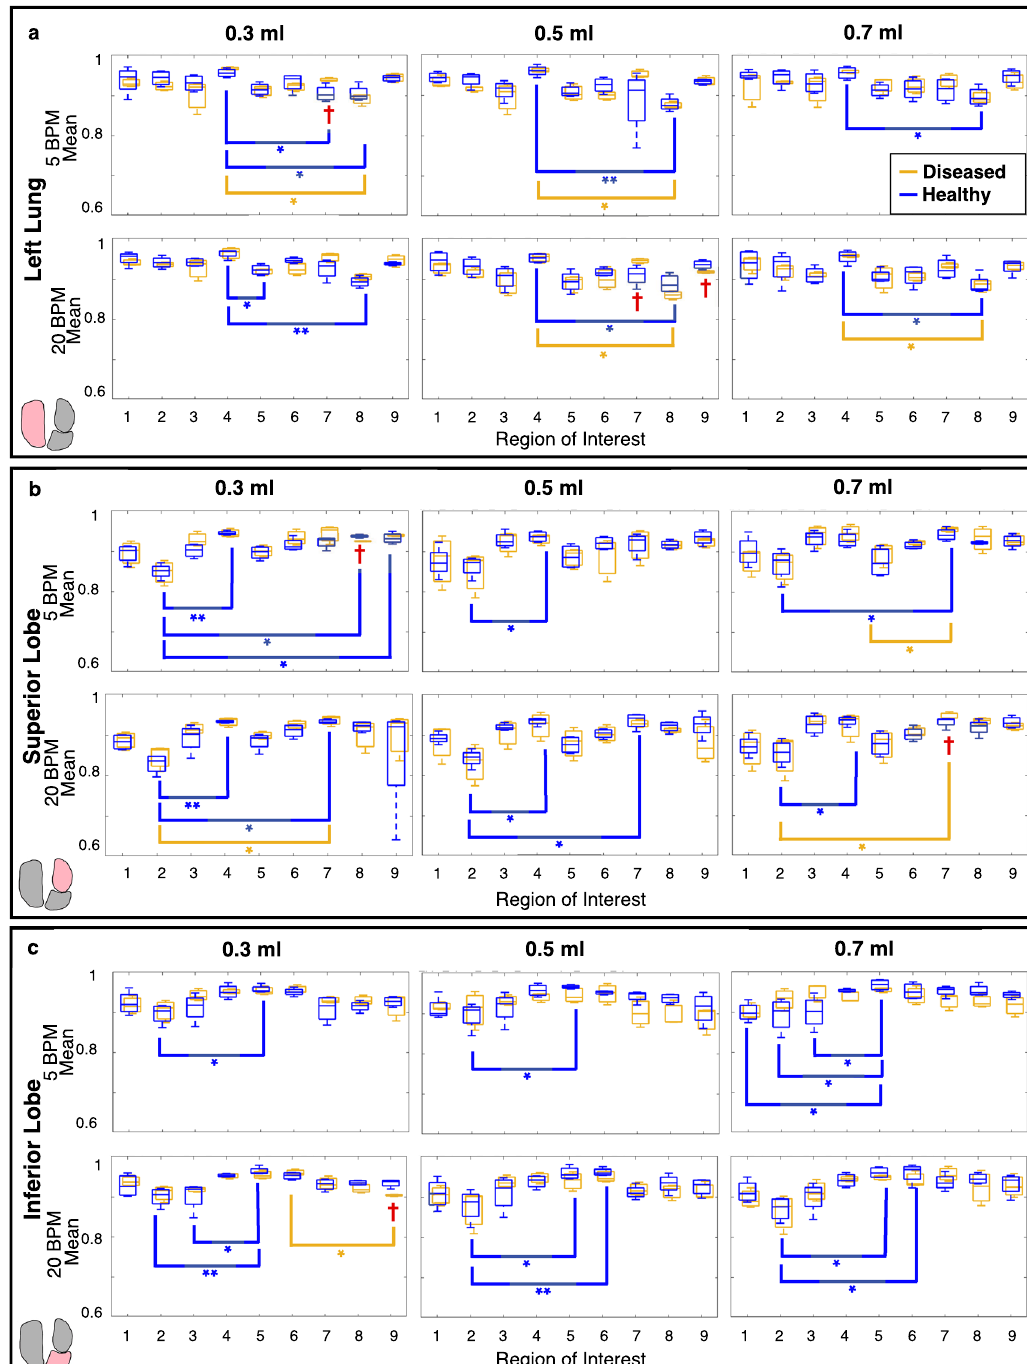
Figure 7. Box and whisker plot representation of diseased (gold) and healthy (blue) strain average anisotropic ratio for each ROI for the ( a ) left lung, ( b ) superior lobe and ( c ) inferior lobe, at each applied volume and breathing rate. Significant diseased versus healthy differences are indicated with red daggers, and significant differences between each of the regions within diseased and healthy lungs’ groups are denoted by gold and blue asterisks,